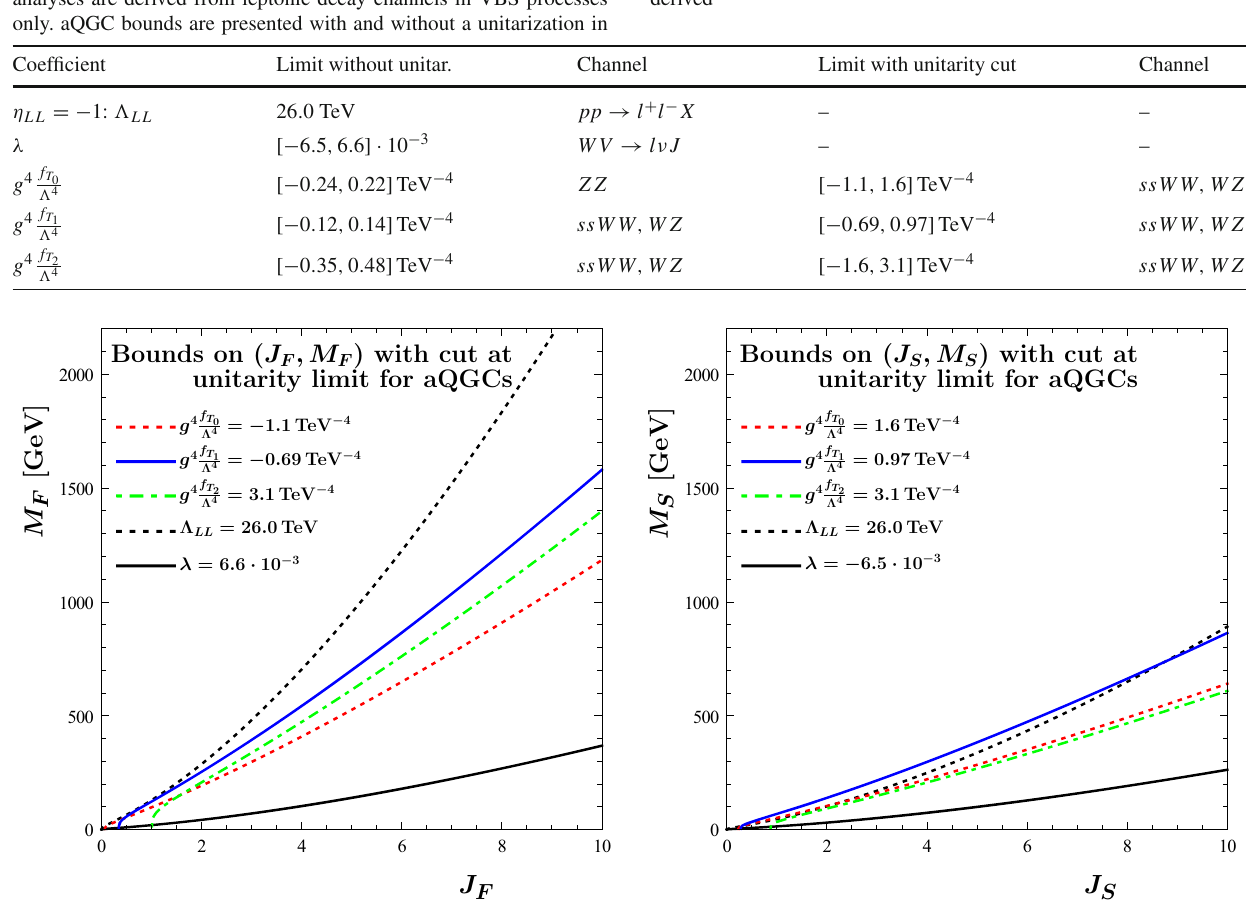
aQGCs, experimental results are derived with a step-function form- factor, cutting off the EFT prediction at the unitarity limit (see Ref. [3] for